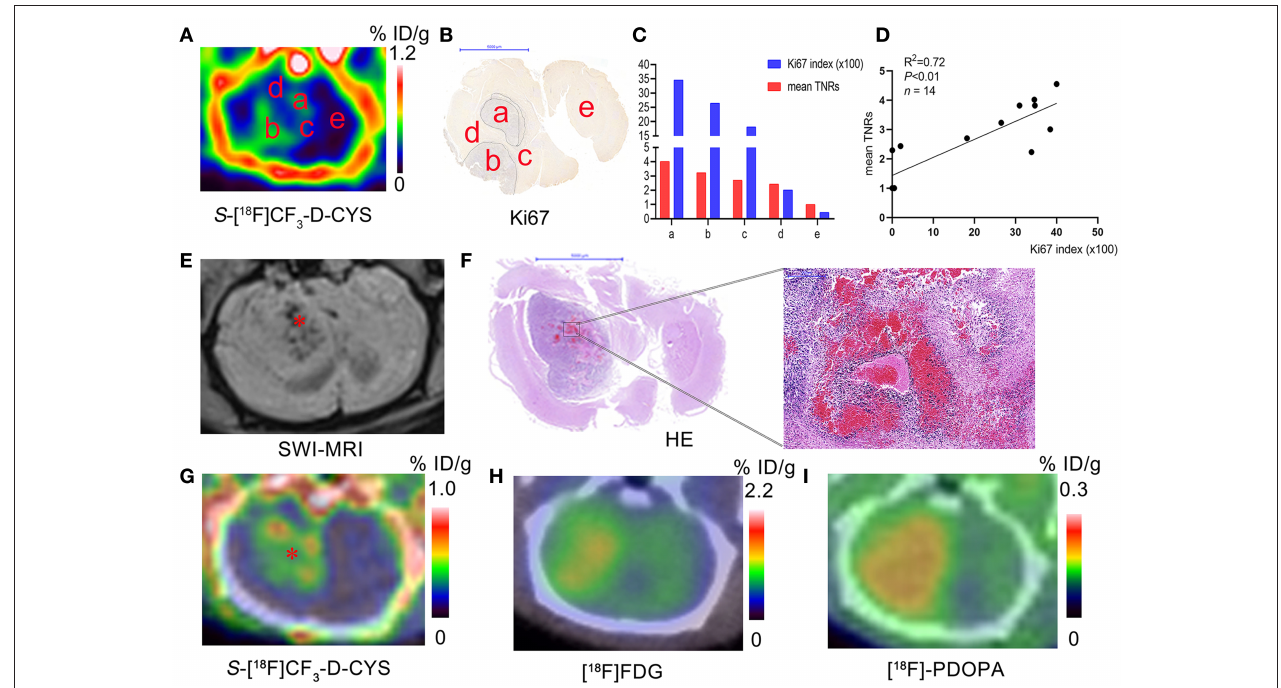
FIGURE 5 | (A–C) Representative S- [ 18 F]CF 3 -D-CYS PET images (A) , the corresponding Ki67 staining image (B) , and the corresponding uptake values and Ki67 index for regions a–e in Panel A (C) (a–e in Panels A–C : different tissue regions; tissue regions marked by the same letters in different corresponding images are considered as the same ones). (D) Correlation analysis between tumor S- [ 18 F]CF 3 -D-CYS uptake values of different regions (such as marked tissue regions a–e in the Panel A ) in several rat models (represented by mean TNRs) and the corresponding Ki67 labeling index. (E–I) The representative SWI-MRI image (E) , HE images of the